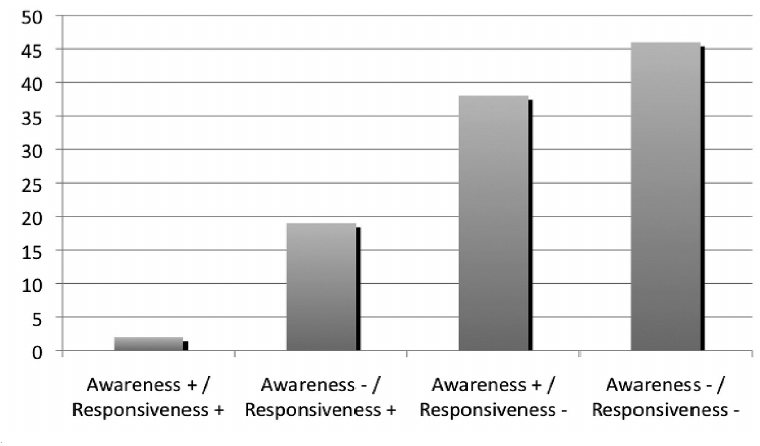
Fig. 1. Percentages of 58 consecutive patients with NEAD self-reporting ‘awareness’ and ‘responsiveness’ during their